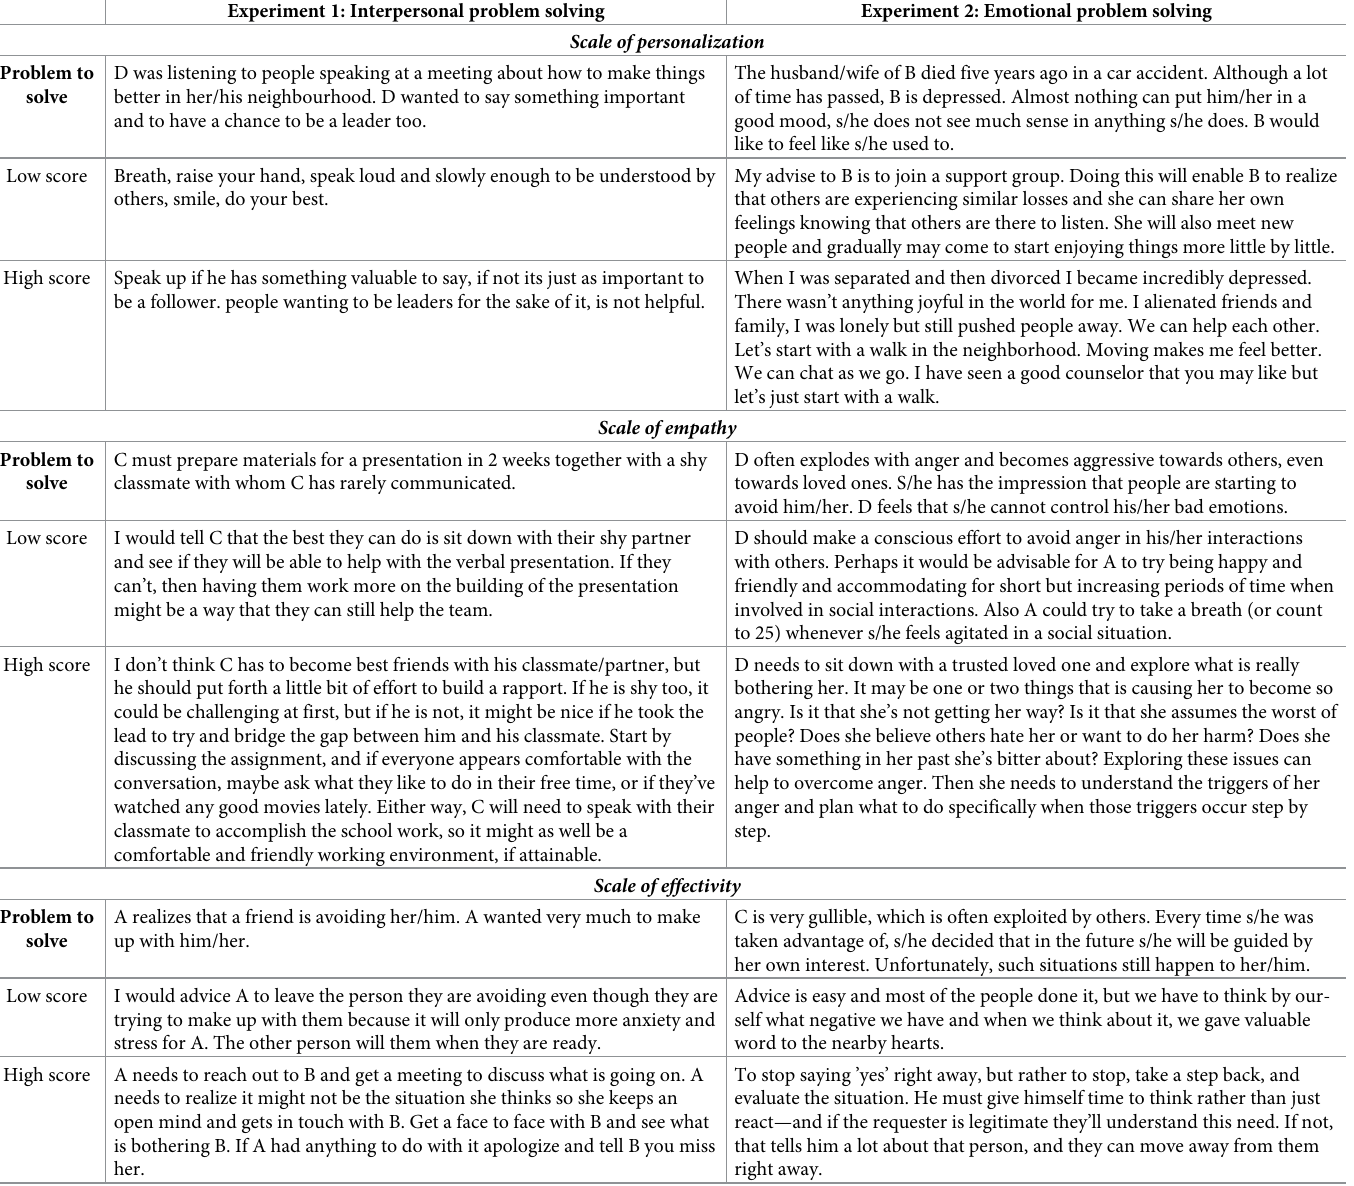
Table 3. Examples from participants’ pieces of advice from both conducted